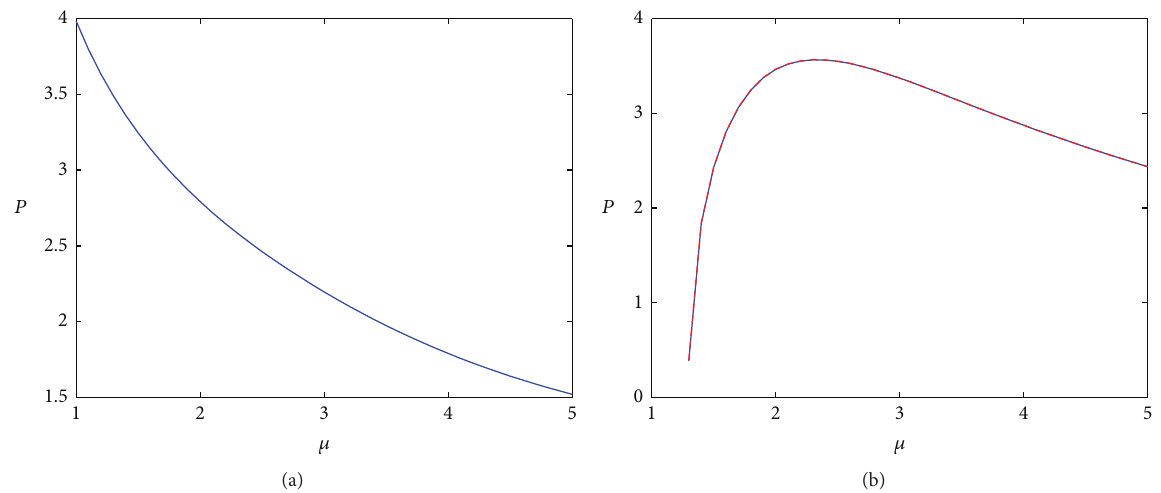
Figure 13: The total power of the lattice solitons versus propagation constant 𝜇 for the self-focusing quintic model. (a) Without external potential, 𝑉 0 = 0 . (b) With the Penrose potential, 𝑉 0 = 3.5 .